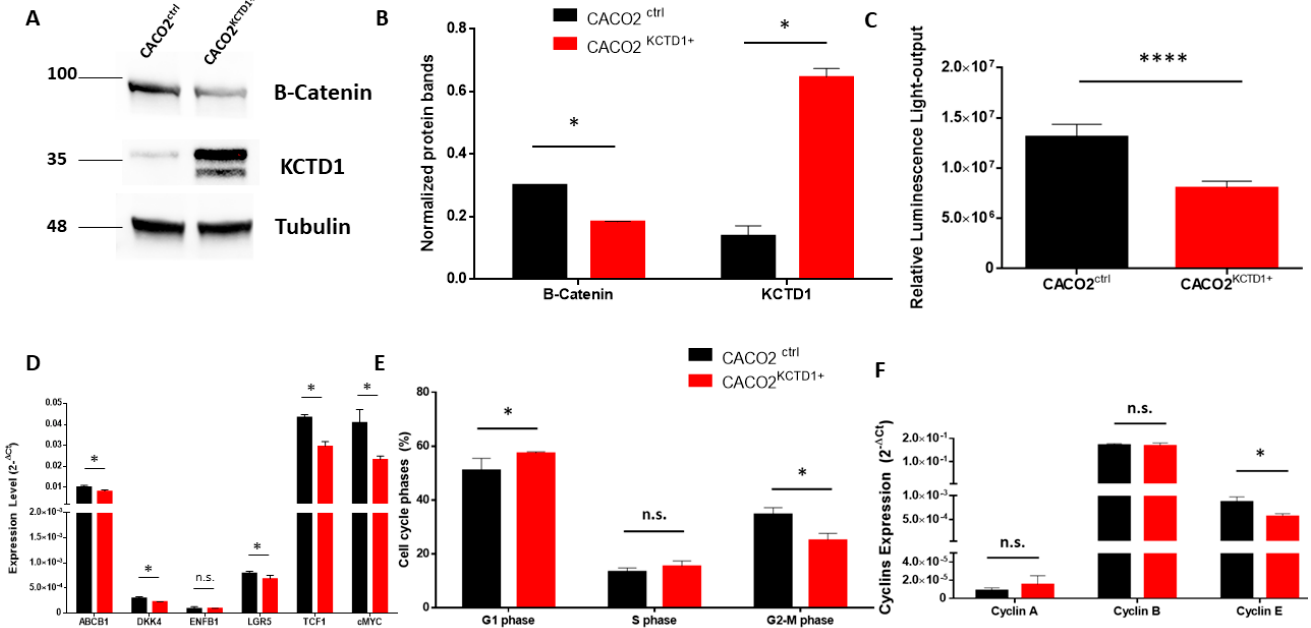
Figure 7. Western blot analysis of the indicated proteins ( A ) and protein band quantifications ( B ) were performed on CACO2 ctrl cells (black bars) and CACO2 KCTD1+ cells (red bars) after 24 h of overexpression. Numbers represent molecular weights of proteins, expressed in kDa. * = p < 0.05. ( C ) ATPlite assay of CACO2 ctrl cells (black bars) and CACO2 KCTD1+ cells (red bars) after 24 h of overexpression. **** = p < 0.001. Mann–Whitney t -test. Error bars represent the SD of four independent experiments. ( D ) β -catenin targets mRNA expression levels in CACO2 ctrl cells (black bars) and CACO2 KCTD1+ cells (red bars). Relative expression was determined using the 2 −Δ Ct method. Relative mRNA expressions of β -catenin targets are shown as mean +/ − SD of three technical independent experiments. * = p < 0.05, Mann–Whitney t -test. ( E ) The percentage of CACO2 ctrl cells (black bars) and CACO2 KCTD1+ cells (red bars) in the G0–G1, S, and G2–M phases after 24 h of KCTD1 overexpression were reported as the means of three independent experiments +/ − SD * = p < 0.05. Mann–Whitney t -test. ( F ) mRNA expression levels of cyclins in CACO2 ctrl cells (black bars) and CACO2 KCTD1+ cells (red bars). Relative expression was determined using the 2 − ∆ Ct method. Relative cyclin expression is shown as mean +/ − SD of three technical independent experiments. ns = not significant; * = p < 0.05, Mann–Whitney t